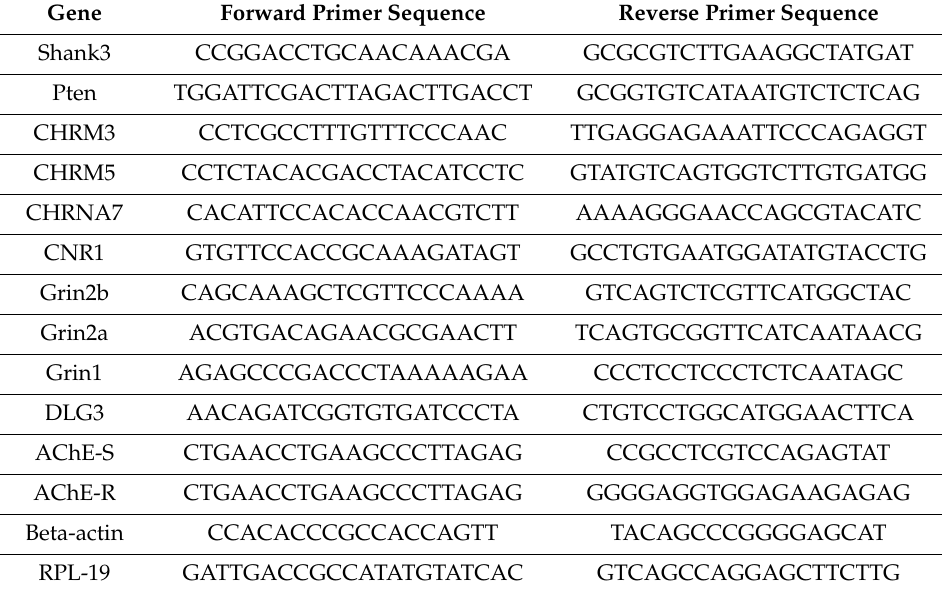
Table 1. Primer pairs for the tested transcripts are listed